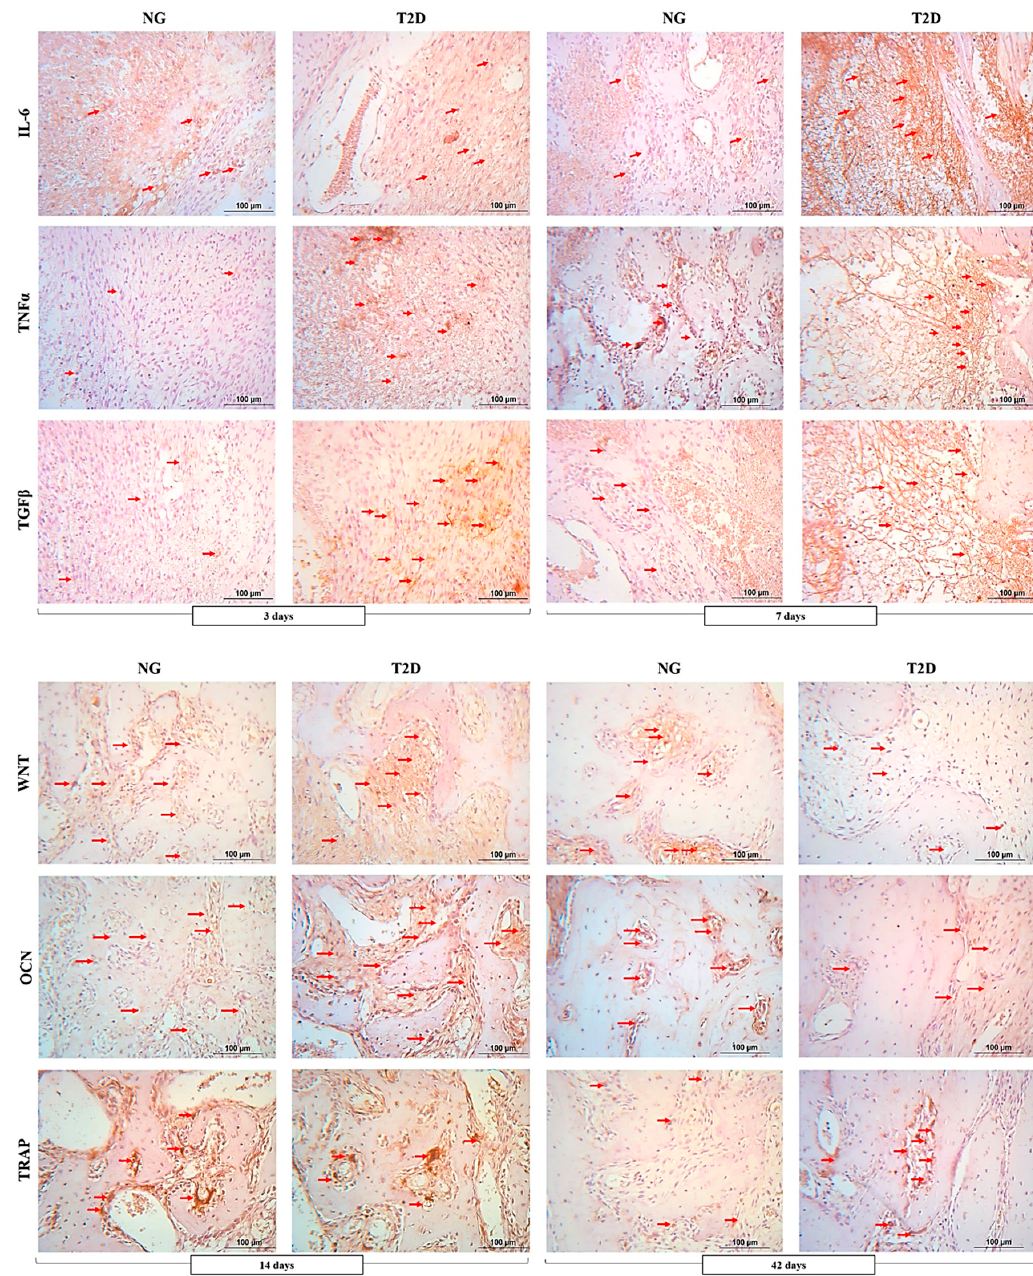
Figure 4. NG and T2D photomicrographs of IL-6, TNF α , TGF β , OC, Wnt and TRAP immunolabeling. To observe inflammatory responses at 3 and 7 days after dental extraction, were evaluated the immunolabeling of IL-6, TNF α and TGF β . To analyze the process of bone formation and bone resorption at 14 and 42 days after dental extraction was evaluated the immunolabeling of Wnt, OC and TRAP. The scores are shown in Table 3. Symbols: red arrows—Immunolabeled cells. Counterstaining: Harris hematoxylin. 25× magnification; 100 μ m scale bar. Table 4. Scores of NG and T2D immunolabeling analysis. Antibodies against IL-6, TNF α , TGF β , OC, Wnt and TRAP.